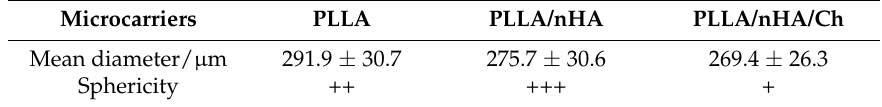
Figure 2. Outline drawings of microcarriers ( A ): PLLA microcarriers; ( B ): PLLA/nHA microcarriers; ( C , F ): PLLA/nHA/Ch microcarriers; ( D ): the PLLA/nHA microcarriers treated with sodium hydroxide for 20 min; ( E ): the PLLA/nHA microcarriers treated with sodium hydroxide for 10 min. ( A – C , D , E , F : 40 × , 100 × , 200 × ; Scale: 250 µ m). Table 1. Analysis of mean diameter and sphericity of microcarriers.